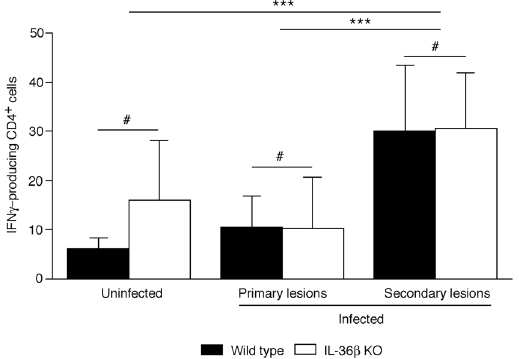
Figure 8. Number of IFN γ -producing CD4 + cells are similar in wild type and IL-36 β KO zosteriform lesions. Wild type (black bars) and IL-36 β KO (open bars) mice were infected with HSV-1 (n = 10 per group) or left uninfected (n = 3–5 per group). Skin was collected 6 days post-infection. Primary lesion sites were collected with 8 mm biopsy punches at the center of the initial infection sites. Upper and lower secondary lesions (Fig. 2b) were excised and pooled. Number of IFN γ -producing CD4 + cell were determined using ELISpot assays. Representative data (means ± SD) from one of two experiments are shown. # p > 0.05; * p < 0.05; ** p <